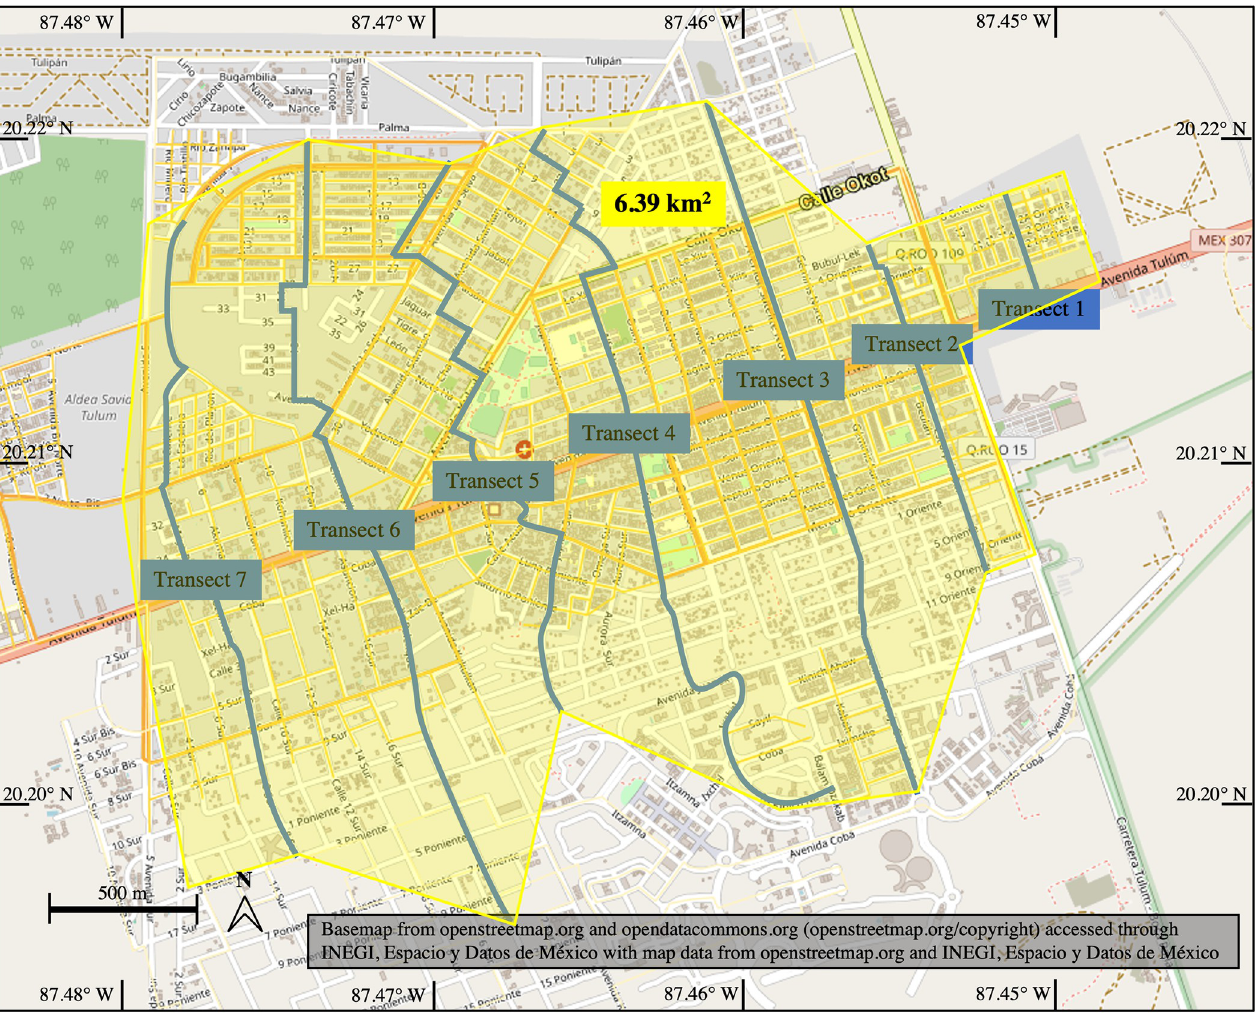
Fig 3. Map of Tulu´m with the sampled area outlined. The sampled transects are